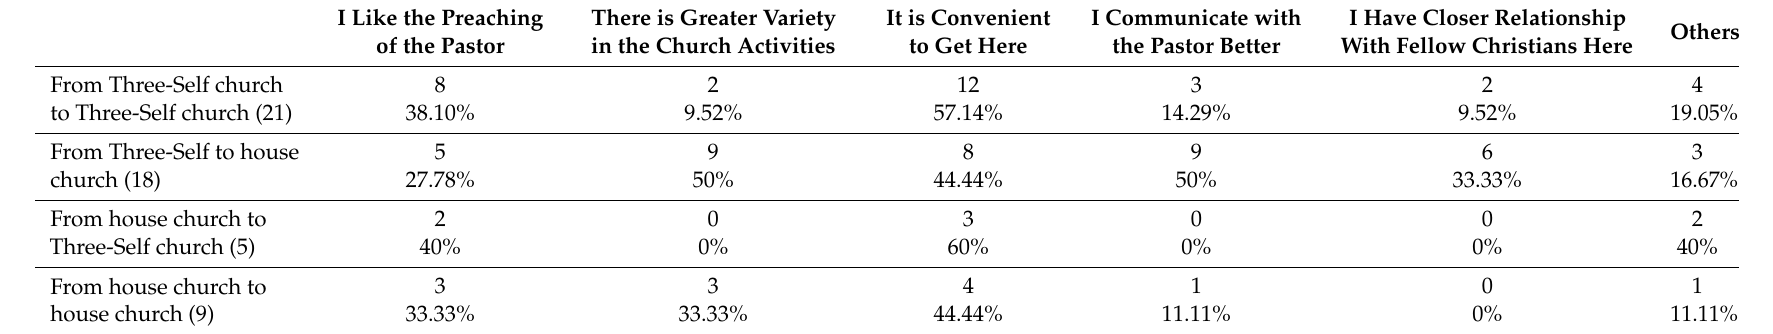
Table 2. Analysis of the reason for the flow of Christians between